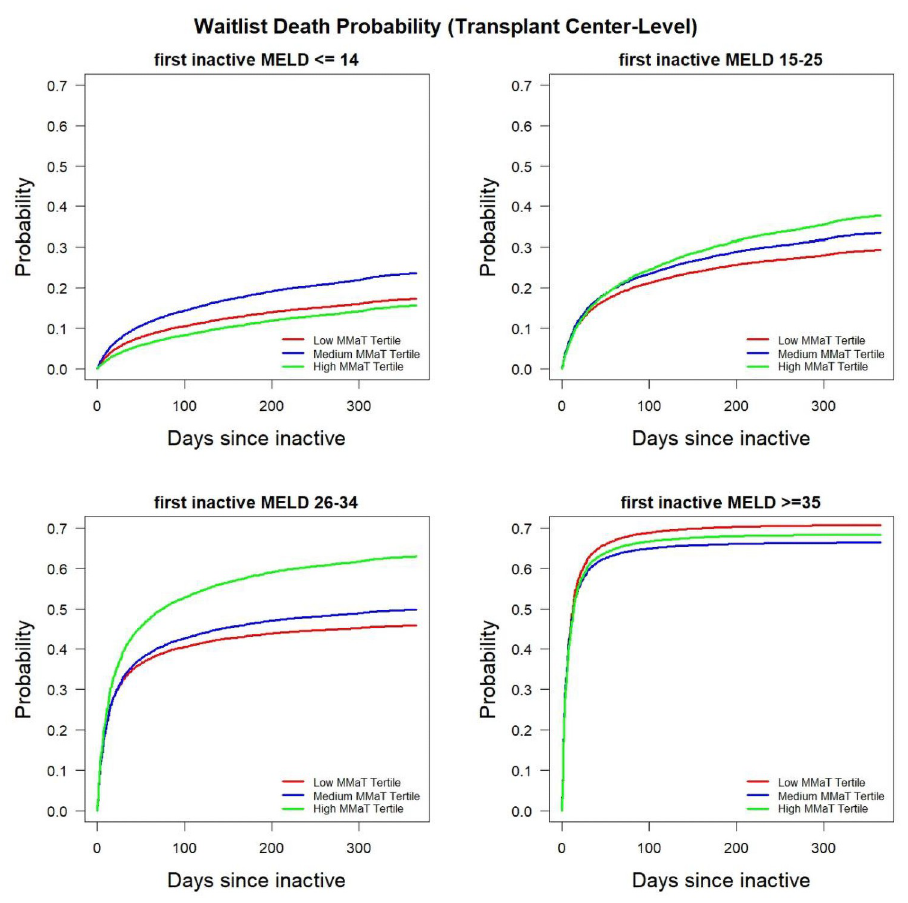
Fig 5. Probability of death among inactive waitlist candidates stratified by candidate MELD group and MMaT at the DSA-level.